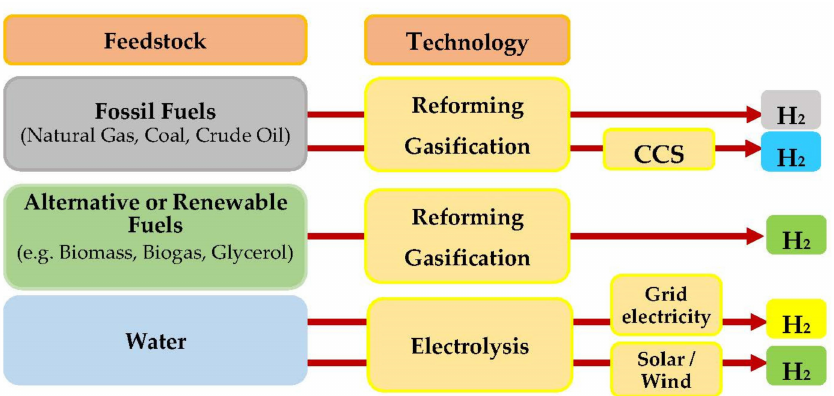
Figure 1. Main routes for H 2 production using commercial technologies: reforming, gasification and